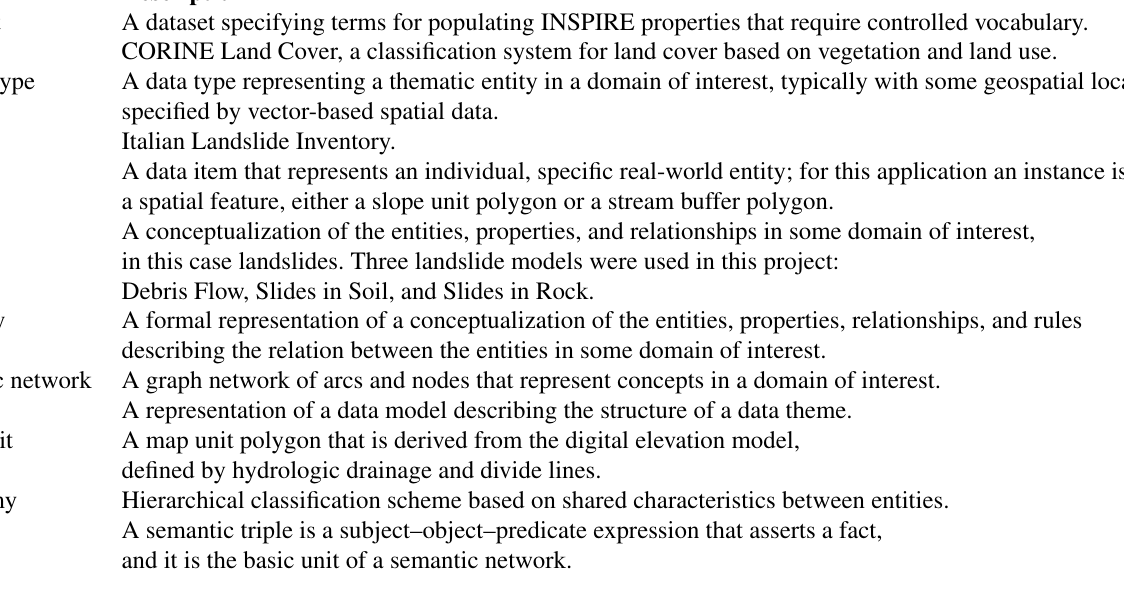
Hierarchical classification scheme based on shared characteristics between